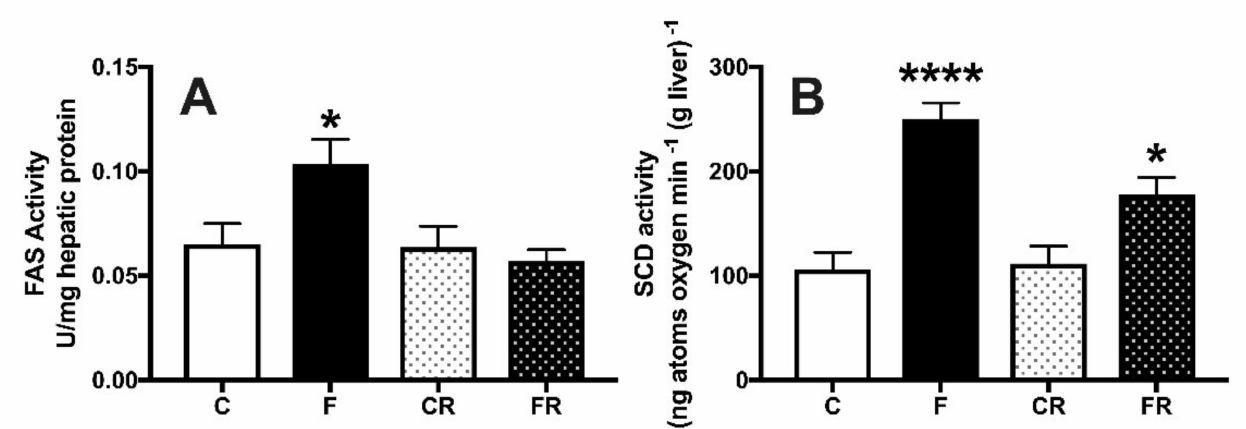
Figure 8. Hepatic activity of fatty acid synthase ( A ) and stearoyl-CoA desaturase ( B ) in control (C), fructose-fed (F), control rescue (CR) and fructose rescue (FR) rats. Values are the means ± SEM of eight different rats. * p < 0.05, **** p < 0.0001 compared to respective control (one-way ANOVA followed by Tukey